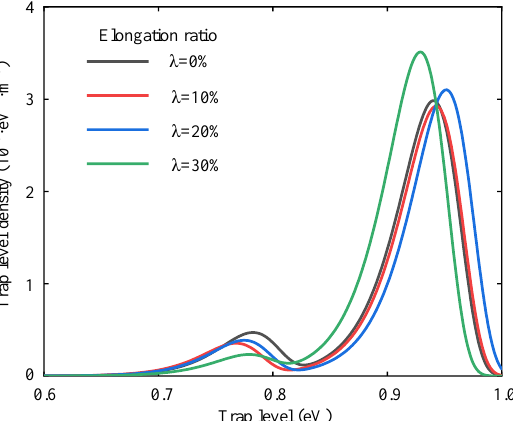
Figure 10. Energy level distribution of polyethylene trap at different elongation ratios.